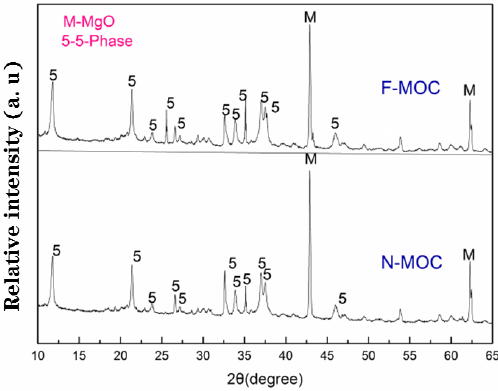
Figure 6. X-ray patterns of F-MOC and N-MOC.